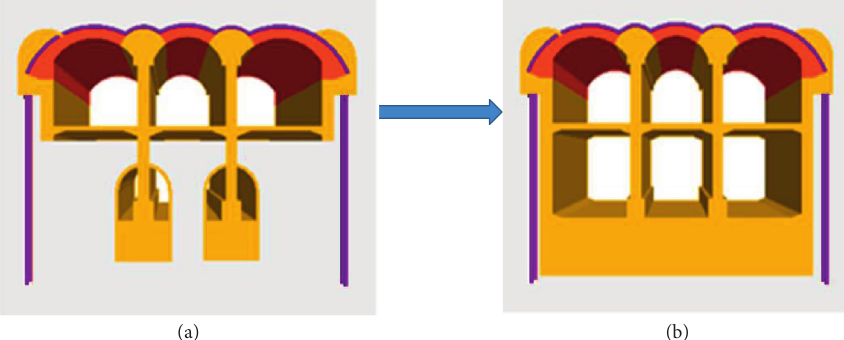
Figure 13: The construction process inside the metro station. (a) Stage 6-1. (b) Stage 6-2.